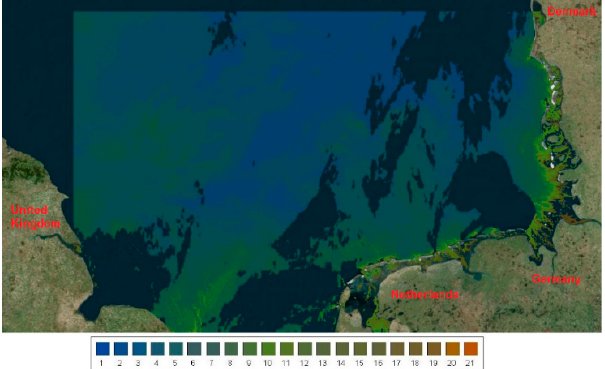
Figure 3. FUI colours derived from MERIS full-resolution imagery captured on 2 May 2009. Image was generated using the online marine data analyser [36].